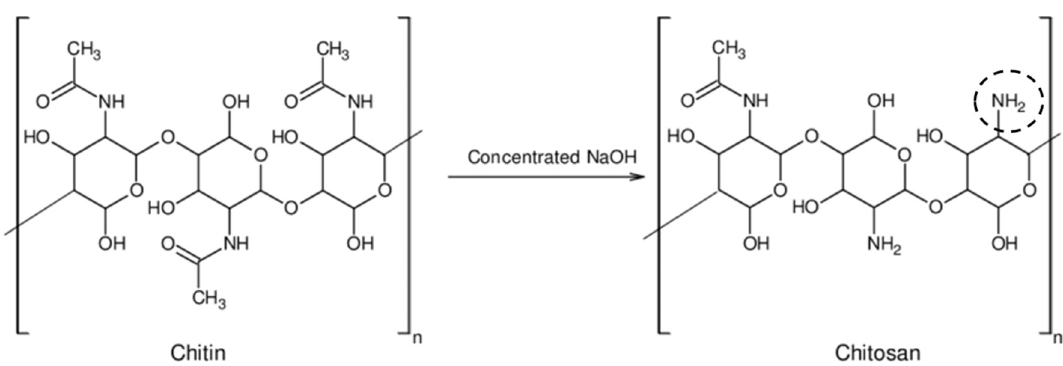
Figure 1. Deacetylation of chitin ( left ) into chitosan ( right ).